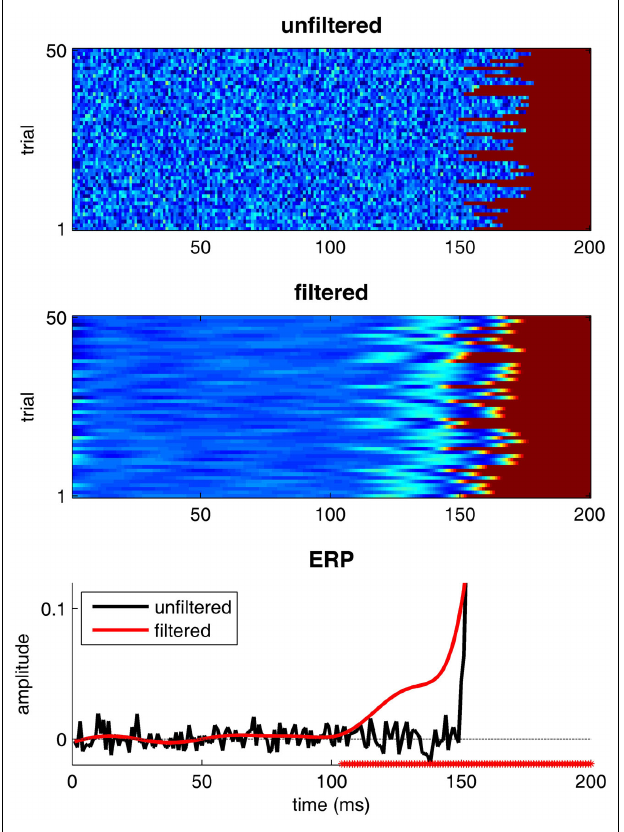
FIGURE 3 |Taking into account subjective responses when contrasting brain signals can generate spurious differences. 1000 trials were simulated, half of them with a stimulus from category A and the other half from category B. For the purpose of demonstrating the existence of response biases, each EEG waveform was drawn randomly with a 1/ f power spectrum, thus approximating the statistics of natural EEG but without any selective response evoked by category A or B. Hence, we should normally expect to obtain flat event-related potentials (ERPs, computed by averaging all trials of each category, with each trial baseline-corrected using the period [ − 50, + 50ms] around stimulus onset). We assume that the observer correctly categorizes 75% of all trials, but on the remaining 25%, the observer decides to respond not on the basis of the stimulus category (A or B), but based on EEG activity during the 200-ms pre-stimulus period: when the average pre-stimulus activity is positive, the observer presses response button A, and button B when the activity is negative. Of course, negative or positive pre-stimulus activity is equally likely to occur regardless of stimulus type, and therefore the ERPs obtained for stimulus categories A (in blue) and B (in red) will be statistically indistinguishable (bottom panel). However, when only the correct trials are included in the ERPs, many trials with negative pre-stimulus activity and response A and many trials with positive pre-stimulus activity and response B will be discarded from the ERPs (because they correspond to “incorrect” categorization). As a result, the ERPs will show a purely artifactual but significant difference during the pre-stimulus period (top panel).